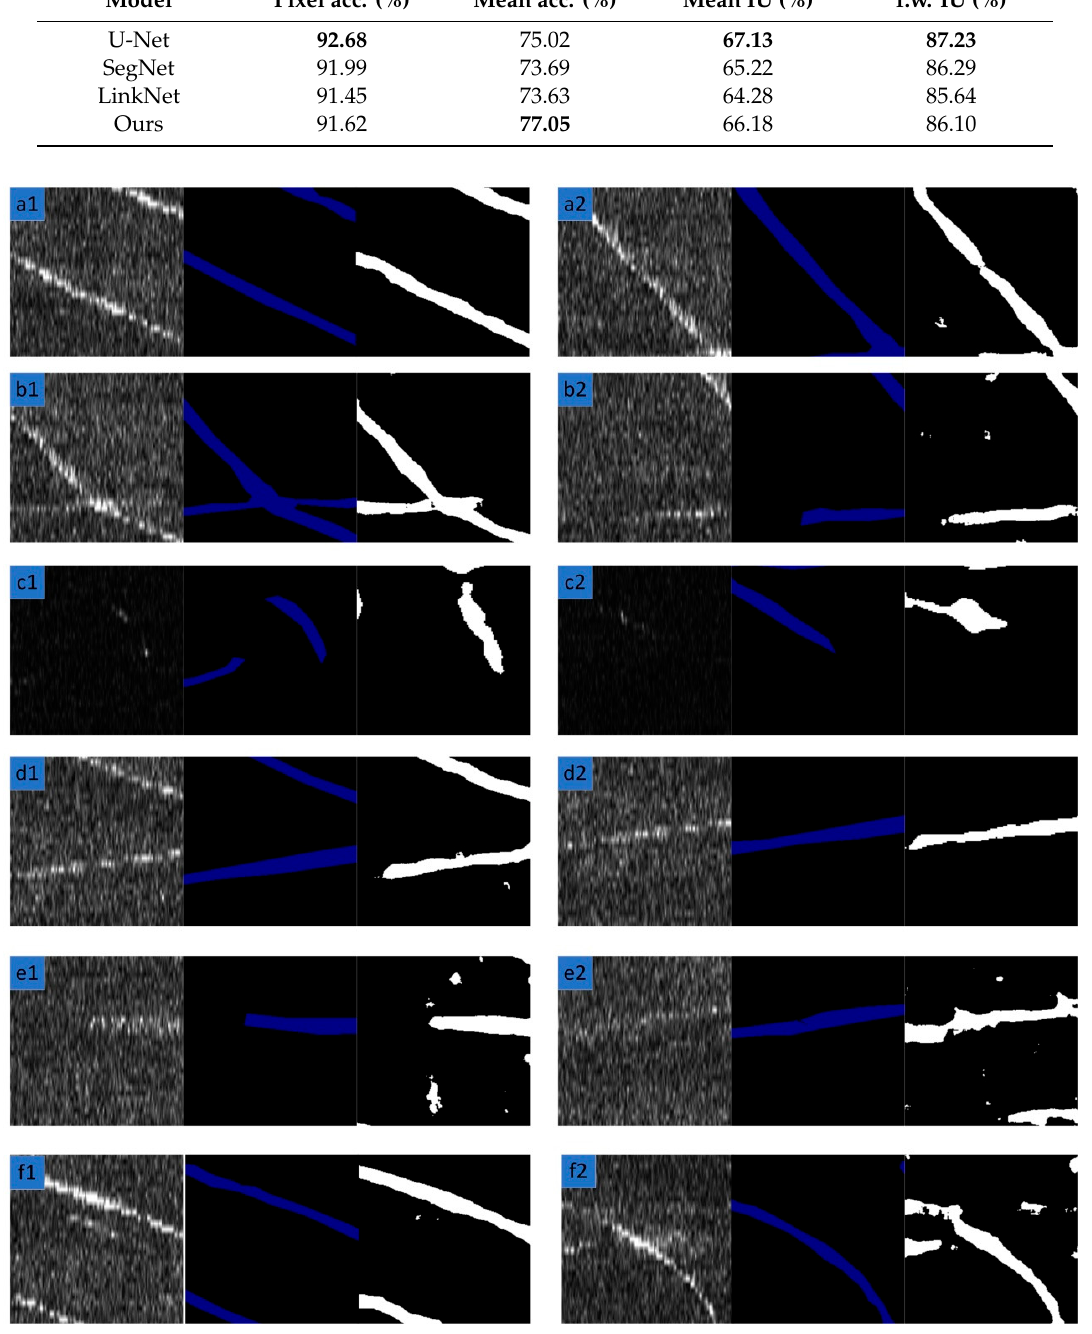
Figure 8. The test results on different data in the test set. From left to right, the images are the original SSS images, their corresponding ground truth and prediction results, respectively. Row1 (a1 and a2): clear and standard. Row2 (b1 and b2): some target pixels are obvious and others are weak. Row3 (c1 and c2): dark. Row4 (d1 and d2): discontinuous. Row5 (e1 and e2): weak and unclear. Row6 (f1 and f2): strong noise.